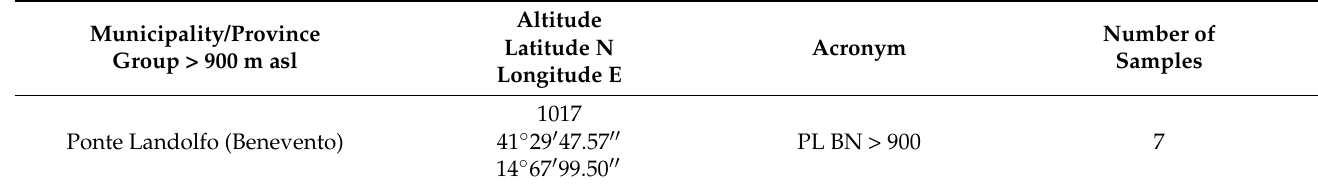
Table 2. Sampling sites located above 900 m asl: sampling municipality/province, altitude, geograph- ical coordinates and acronyms used in the study are